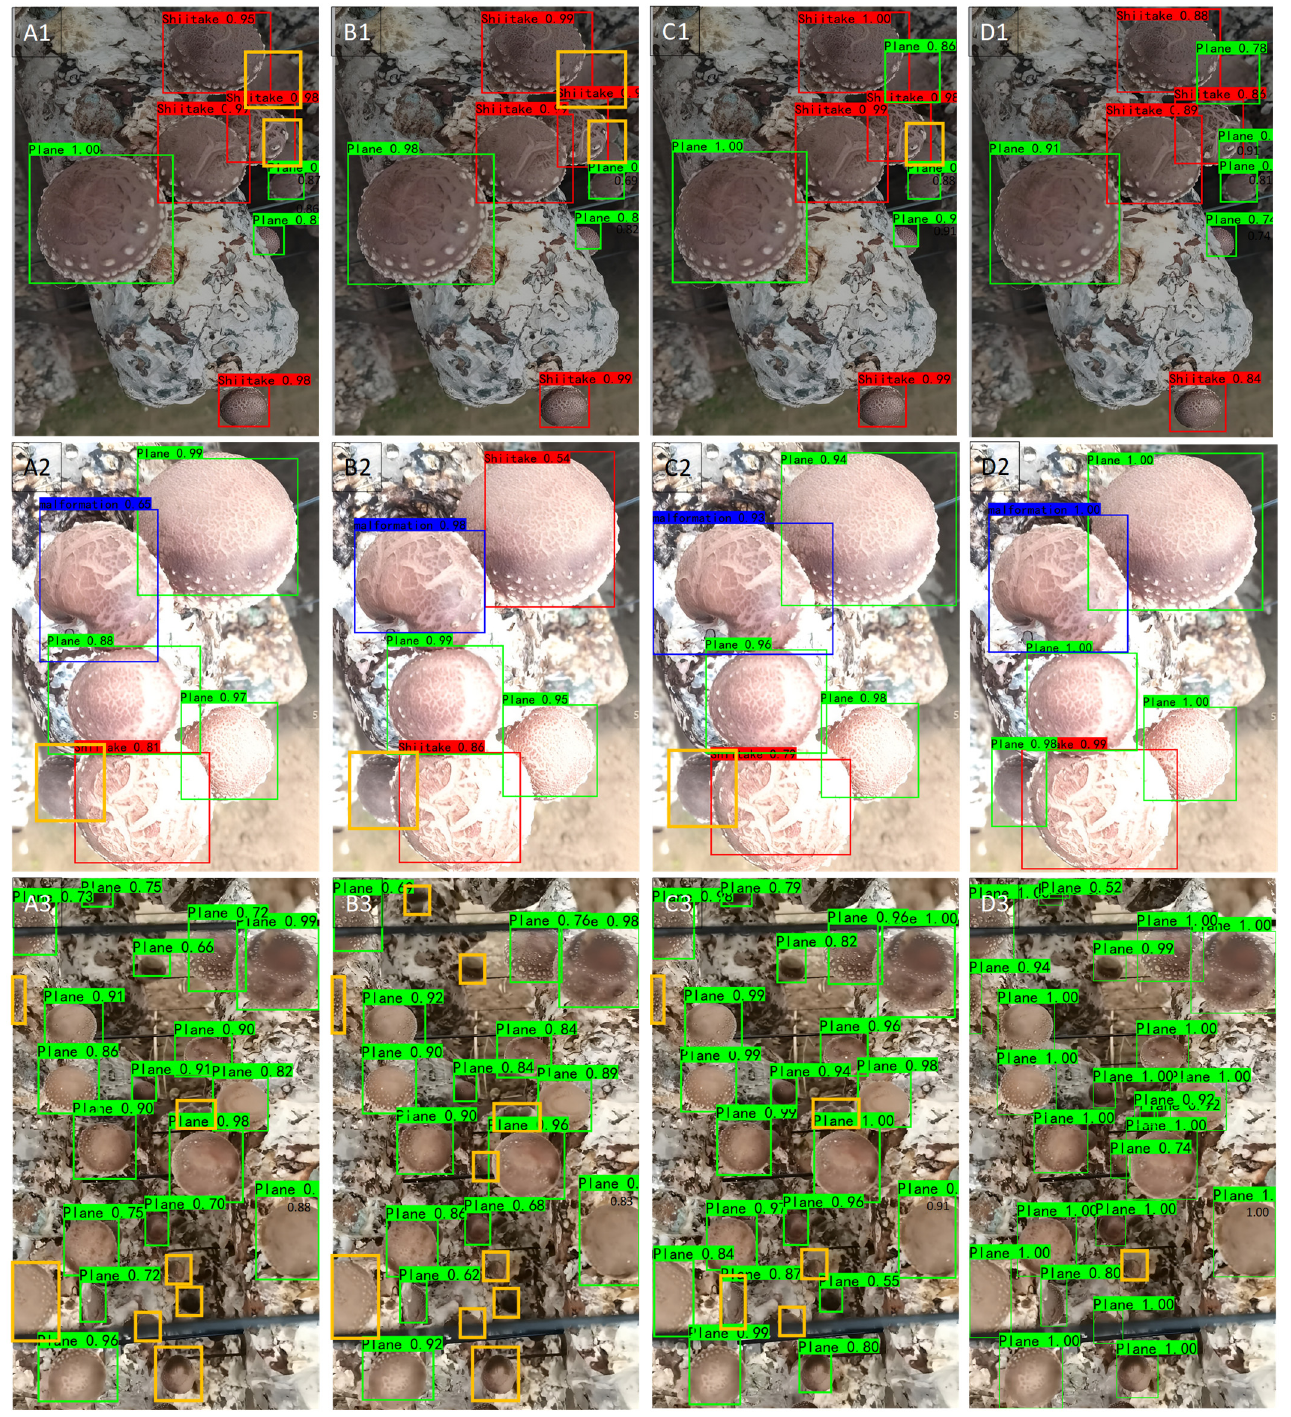
Figure 13. Comparison of improved module performance. (The yellow box is the target of the missed